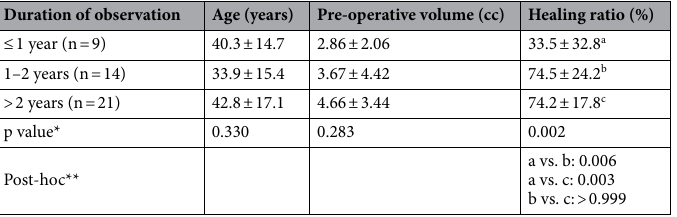
Table 2. Volumetric analysis of spontaneous bone healing after cyst enucleation based on duration of observation. *Kruskal–Wallis. **Mann–Whitney U test with Bonferroni’s correction.